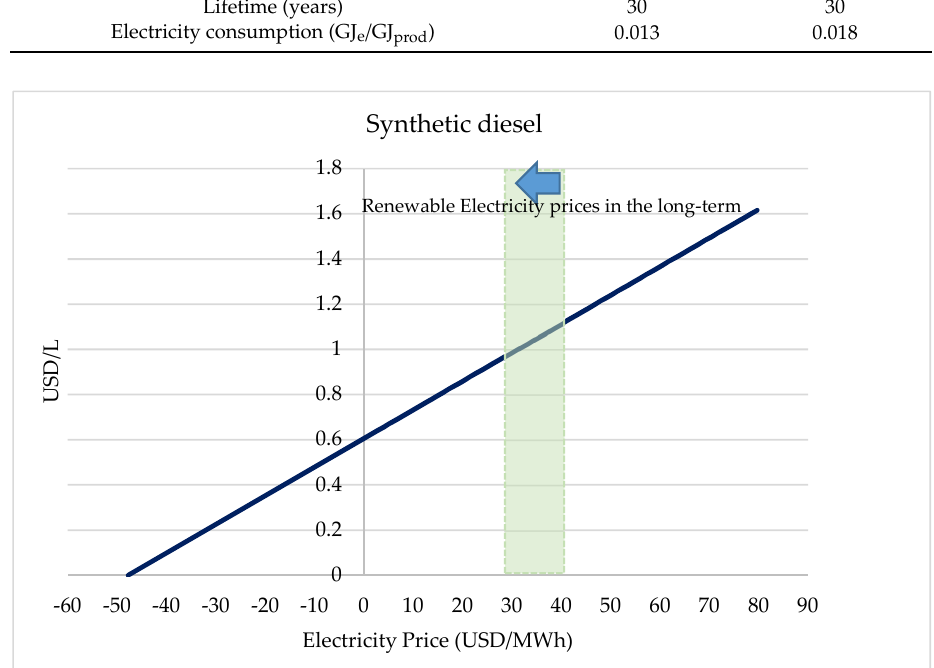
Figure 4. Synthetic diesel production cost based on 3000 FLH (full load hours) of electrolyser. Negative electricity prices reflect local intermittent excess production (extrapolated from the original data). For more information on the underlying assumptions refer to [25].